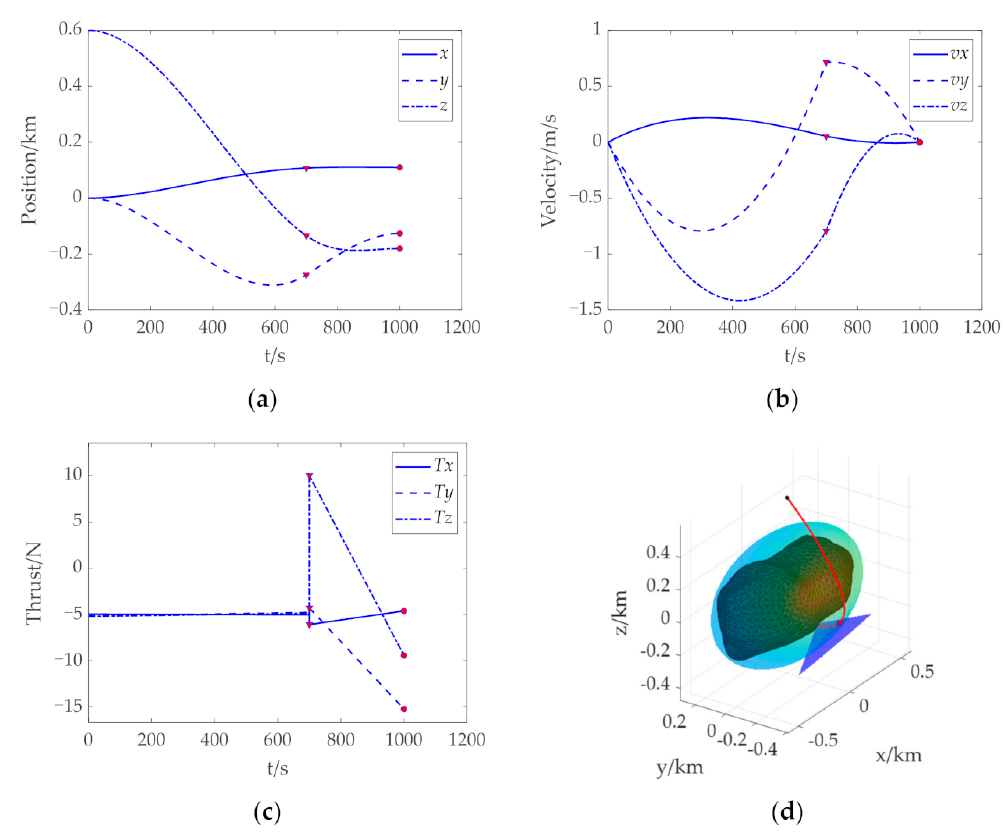
Figure 11. Trajectory optimization results of landing on the asteroid Bacchus from above the North Pole. ( a ) Histories of the position. ( b ) Histories of the velocity. ( c ) Histories of the thrust. ( d ) History of the descent trajectory. The red “ ∆ “ and “ • ” indicate the transition position and landing position,